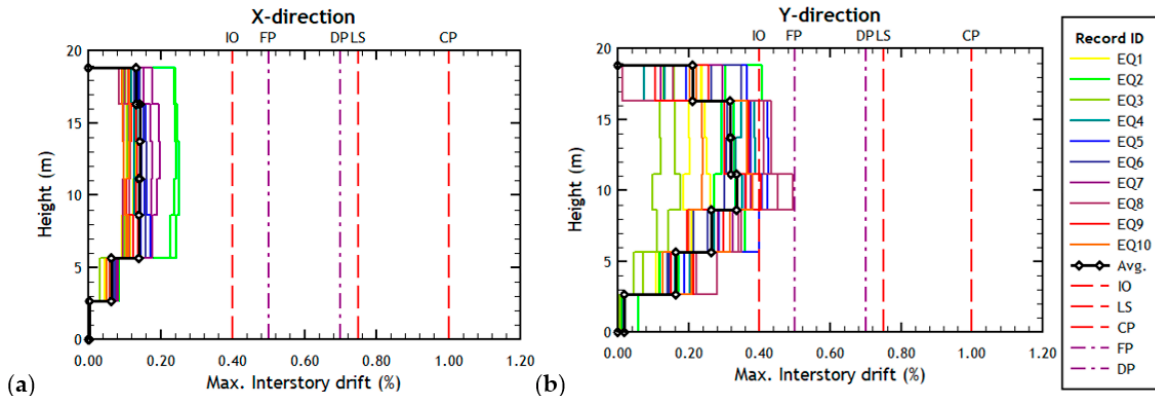
Figure 14. Interstory drift in ( a ) X-direction and ( b ) Y-direction, as obtained from NLTHA for the earthquakes in Table 3. The ASCE-SEI 41-17 (red dashed vertical lines) and ACHISINA limits (purple dash-dot vertical lines) are also plotted in the figure. IO (immediate occupancy), LS (Life Safety), CP (Collapse Prevention), FP (Fragile Partitions), and DP (Ductile Partitions).